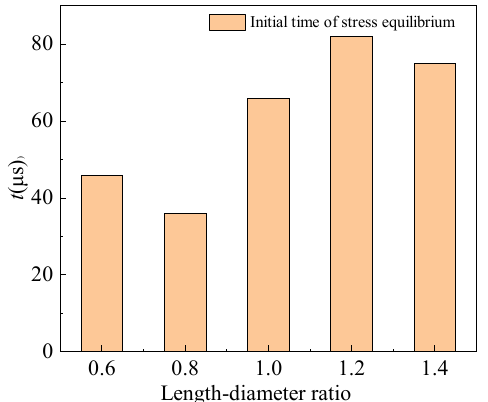
Figure 4. Initial time of stress equilibrium.